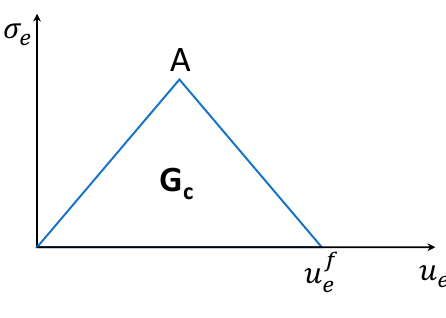
Figure 3. Linear material softening.